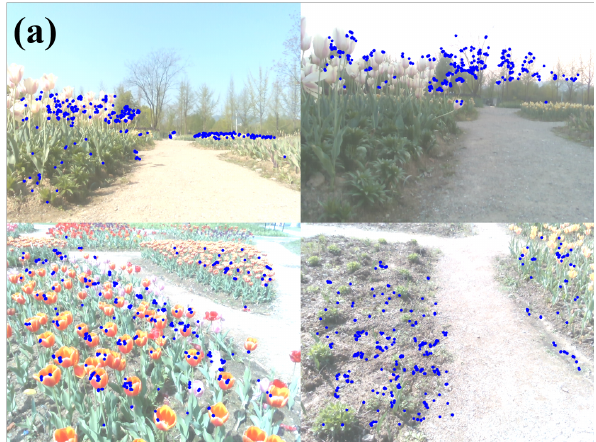
Figure 12. Original images from four different scenes: ( a ) Normal light scene; ( b ) weak light scene; ( c ) high texture scene; ( d ) low texture scene.